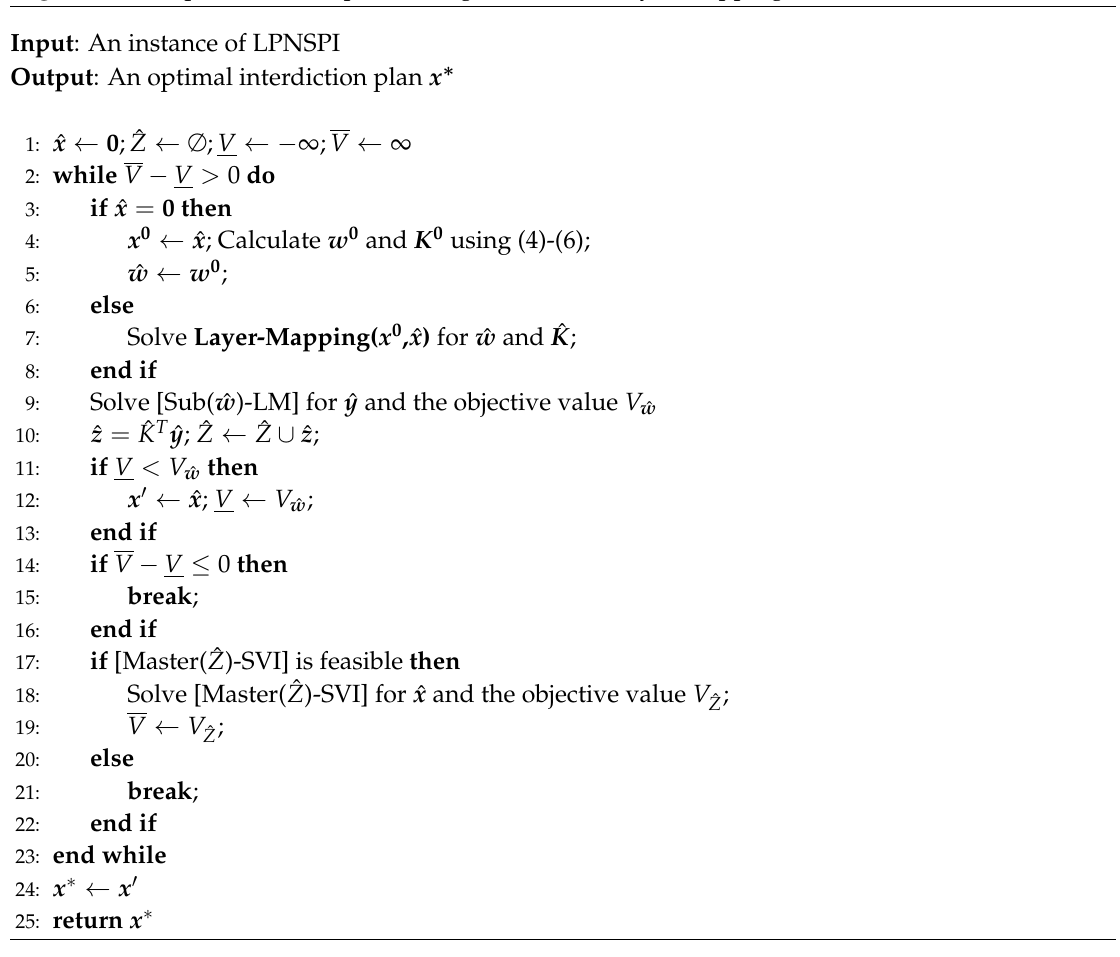
Algorithm 3 Improved decomposition algorithm with